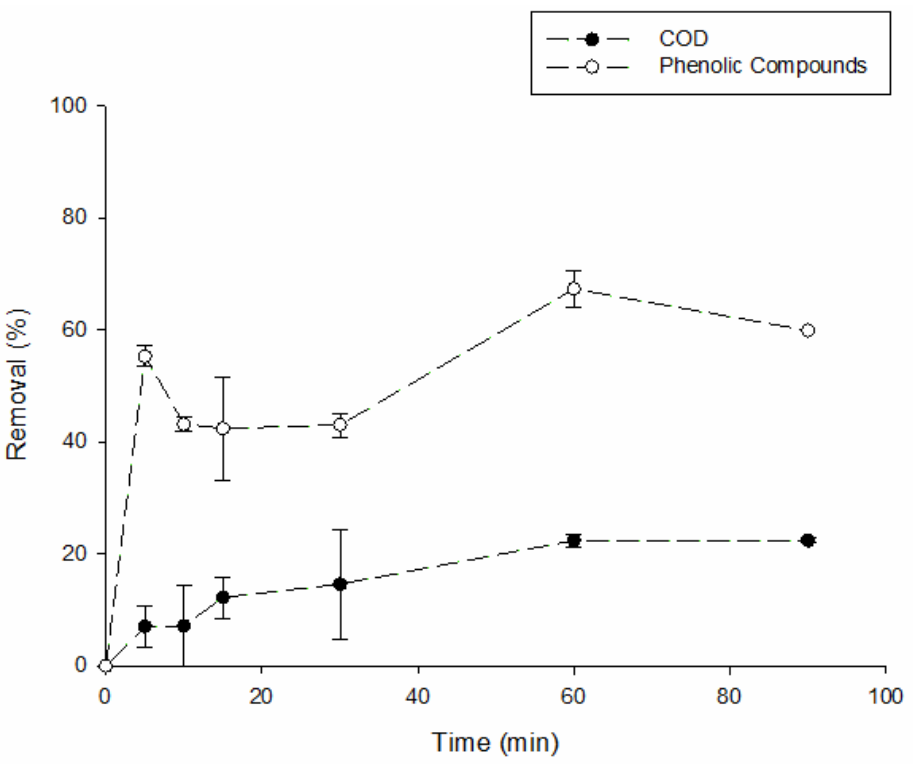
Figure 4. Time influence on COD and phenolic compounds removal during PMS activation by UV-A light (pH = 3 and [PMS] = 1600 mg/L).